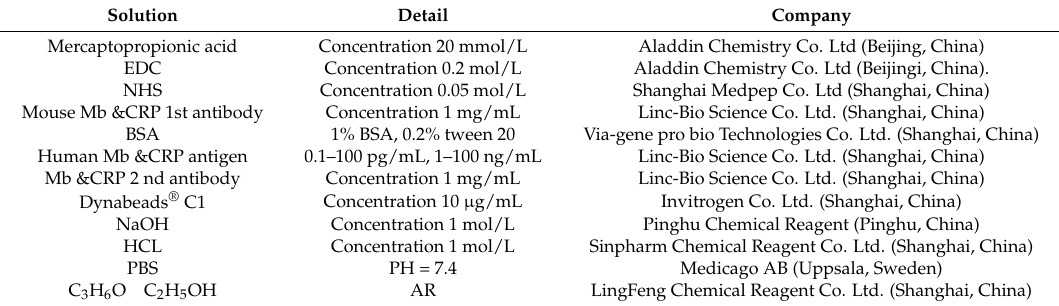
Table 1. Biological and chemical